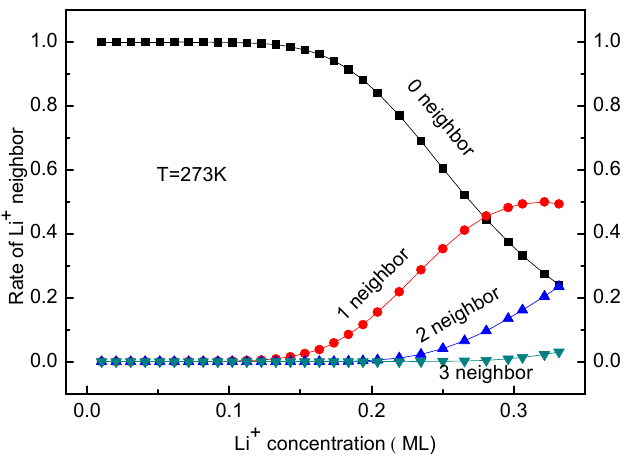
Figure 7. Rates of Li + with 0–3 neighbors at T = 273 K for different Li ion concentration.